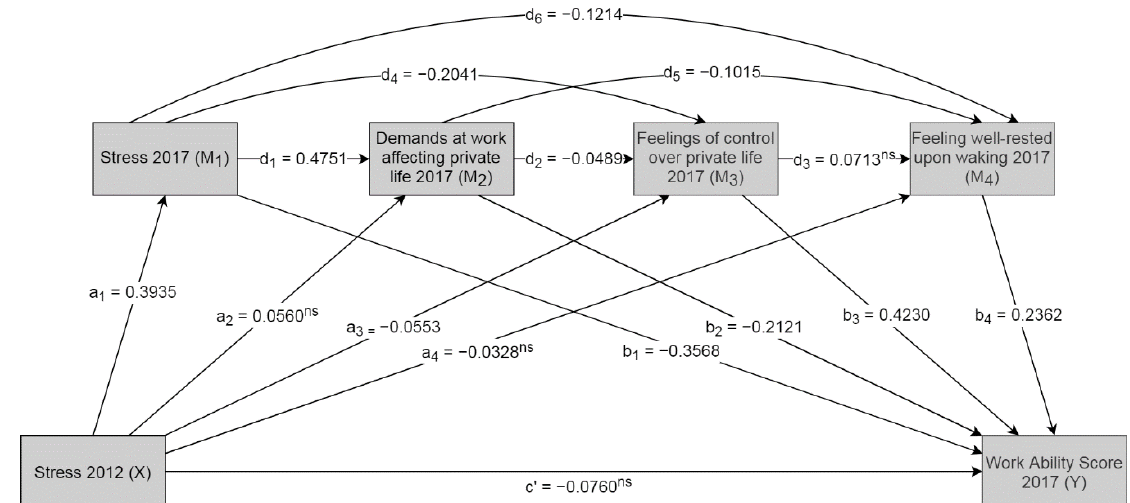
Figure A6. Quadruple mediation with individual e ff ect per path for females. All paths are significant Figure E2: Quadruple mediation with individual effect per path for females. All paths are significant p < 0.05, except a 2 , a 4 , d 3 , and c (cid:48) p < 0.05, except a 2 , a 4 , d 3 , and c’.